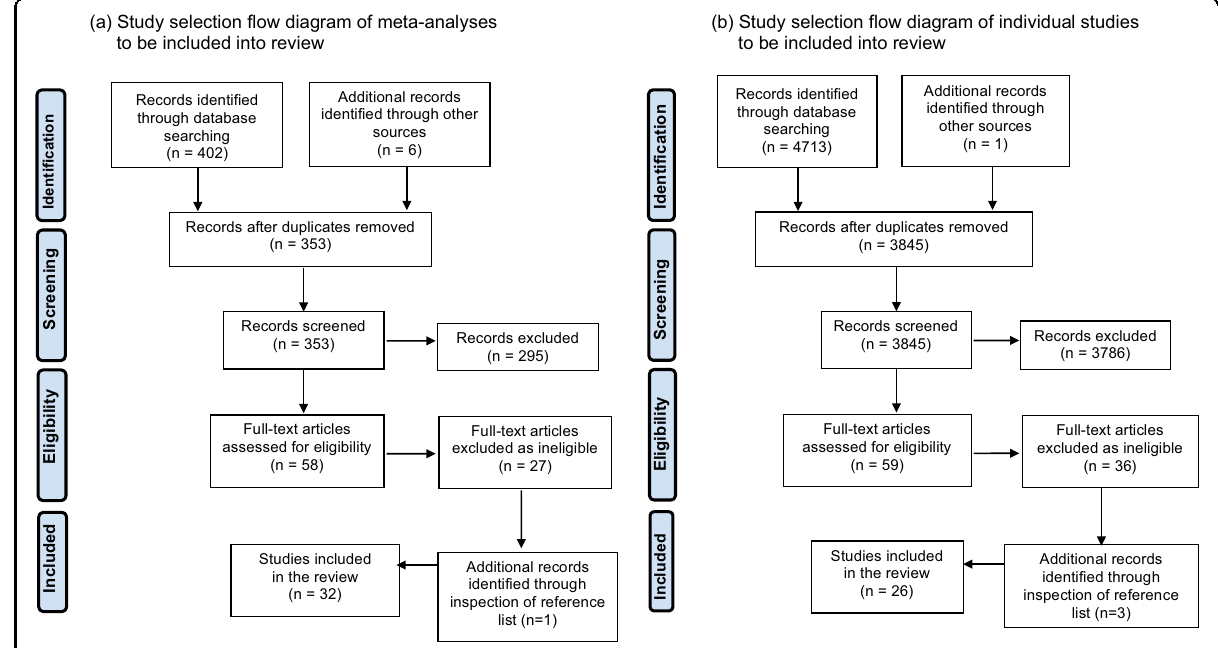
Fig. 2 Study selection fl ow diagram of studies included in review. Study selection fl ow diagram of ( a ) meta analysis and ( b ) individual studies. No meta-analyses investigated associations between maternal asthma and ASD or ADHD, low socioeconomic status and ASD, or maternal infection and ADHD in offspring. A second search to look for individual states examining these associations was performed and included into the